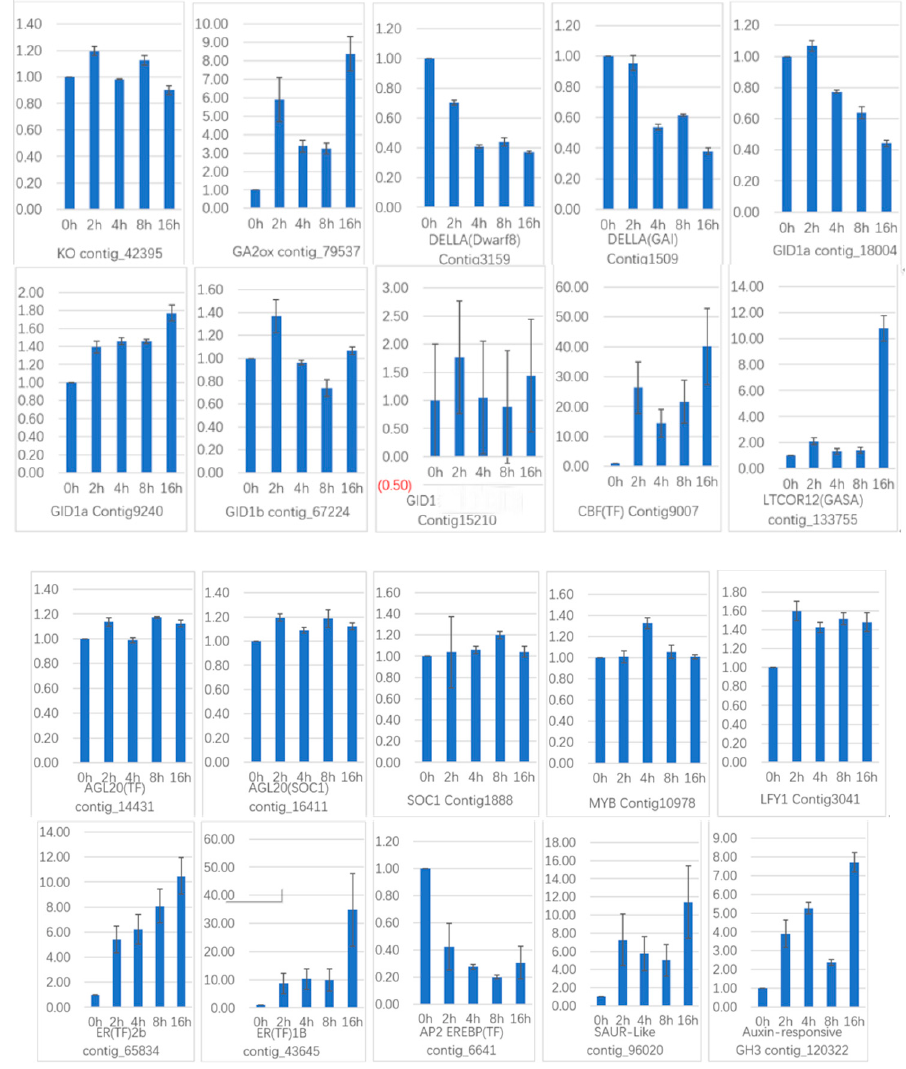
Figure 20. qRT-PCR of 20 key genes selected from transcriptome data.